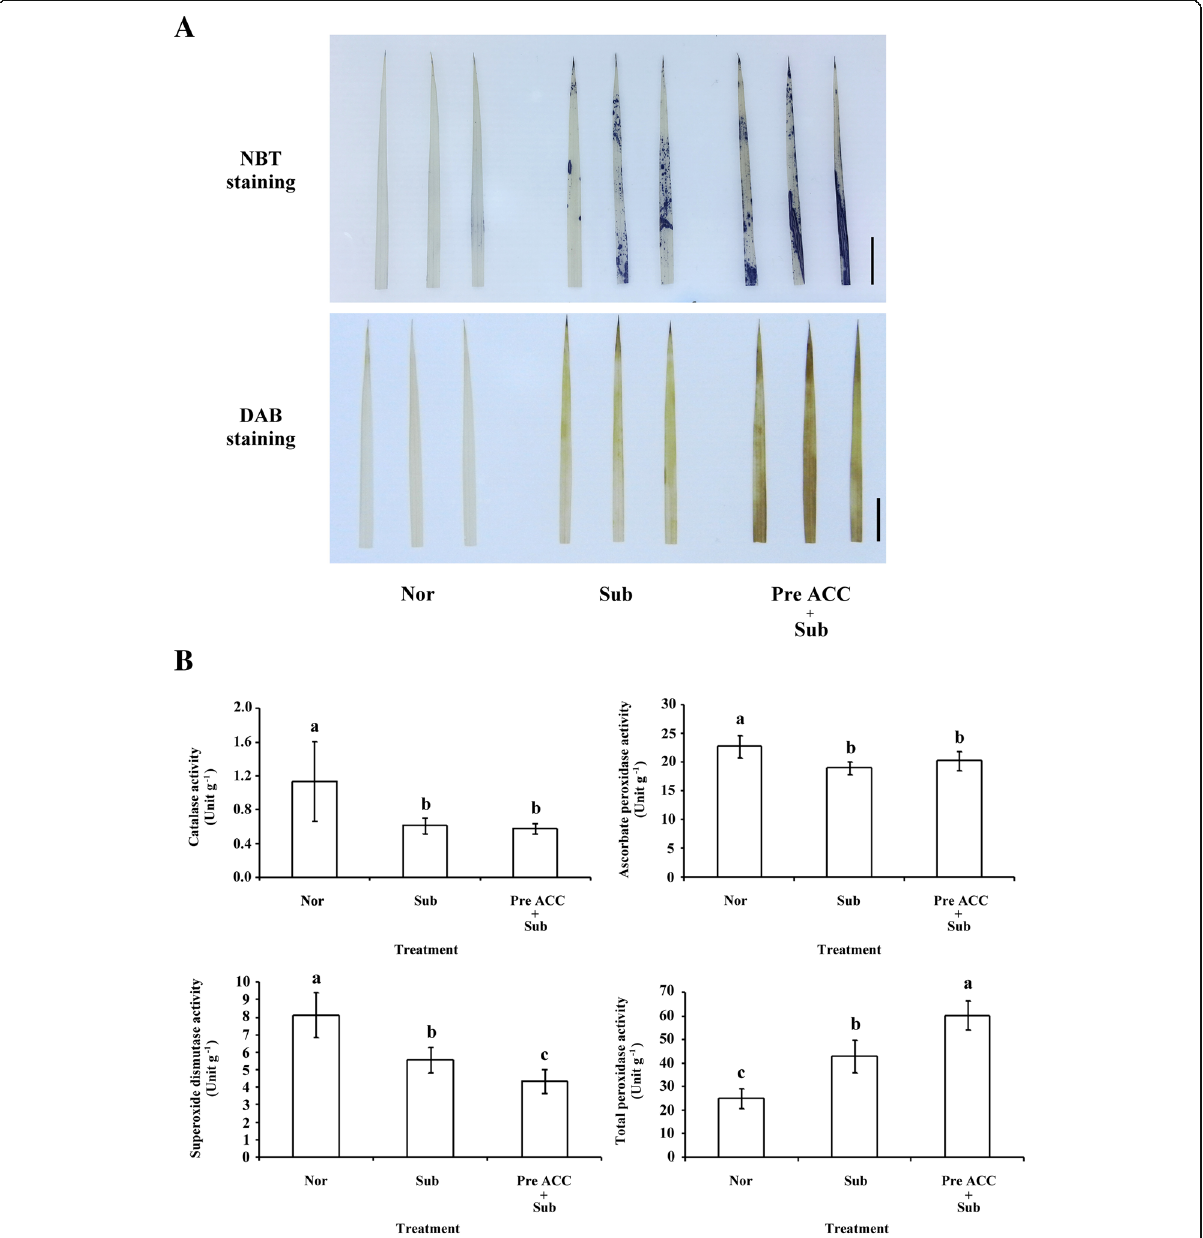
Fig. 5 The detection of O 2 − and H 2 O 2 accumulation and antioxidative enzyme activity assay in rice seedlings pretreated with an ethylene precursor under submergence conditions. a The NBT and DAB staining methods for detecting the accumulation of O 2 − and H 2 O 2 in detached leaves of 8-day-old TK9 rice seedlings treated under Nor, Sub, and Pre ACC + Sub for 2 days and then subjected to submergence for 4 days. Same results were obtained in three independent experiments. Photograph exhibits results of three independent leaves. Bar = 1 cm. b The enzyme activity of detached leaves of 8-day-old TK9 rice seedlings treated under Nor, Sub, and Pre ACC + Sub for 2 days and then subjected to submergence for 4 days. CAT, APX, SOD, and POX activities are the average values ± standard deviation of three biologically independent experiments each with duplicate samples. The values with different letters are significantly different at P < 0.05, according to a one-way ANOVA with post hoc Duncan ’ s